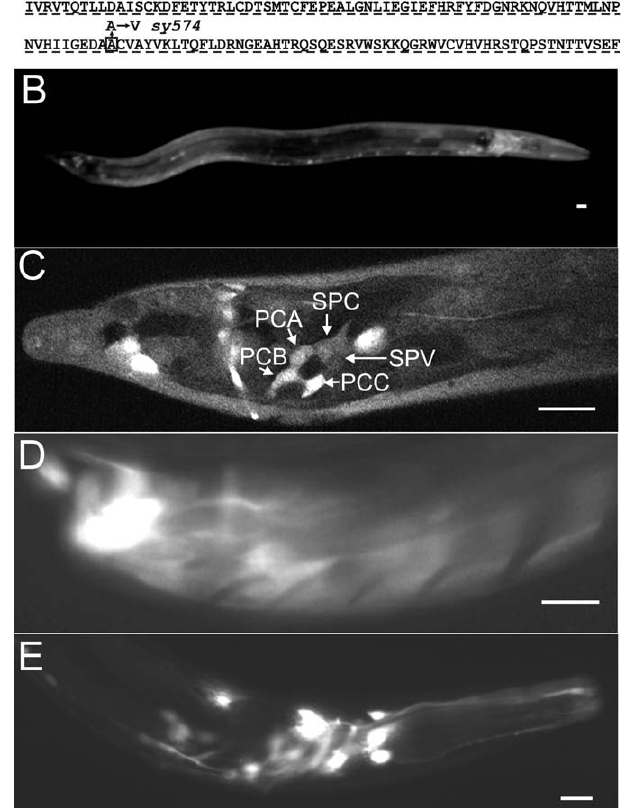
Figure 1. CaMKII/UNC-43 Amino Acid Changes Due to Mutations, CaMKII/ unc-43, and EAG K þ Channel/ egl-2 Expression Patterns (A) Amino acid sequence of UNC-43 isoform g. The underlined region indicates the catalytic domain of CAMKII/UNC-43, the non-underlined region is the autoinhibitory domain, and the dashed underline indicates the self-association domain. unc-43(sy574) and unc-43(e408) point mutations are indicated by boxes. The amino acid change is listed next to the allele name. (B) unc-43 promoter:CFP expression in a L4 male. (C) unc-43 promoter:CFP expression in the L4 male tail. Arrows indicate neurons involved in male mating. (D) egl-2 promoter:YFP expression in an adult male tail. (E) egl-2 promoter:YFP expression in the adult male head. In all figures, anterior is to the right, dorsal is to the top. Scale bar ¼ 10 l M.